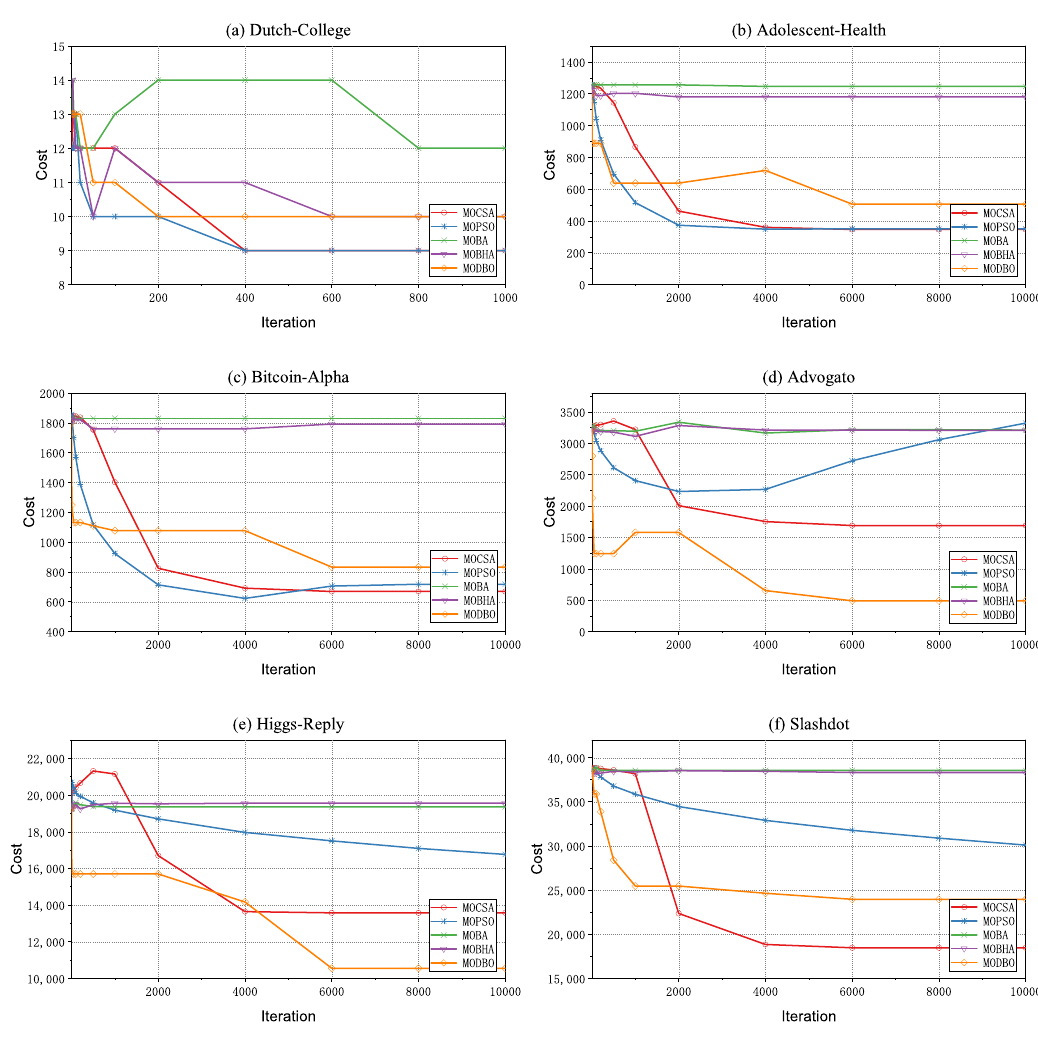
Figure 5. The seed nodes cost of different algorithms on six real social